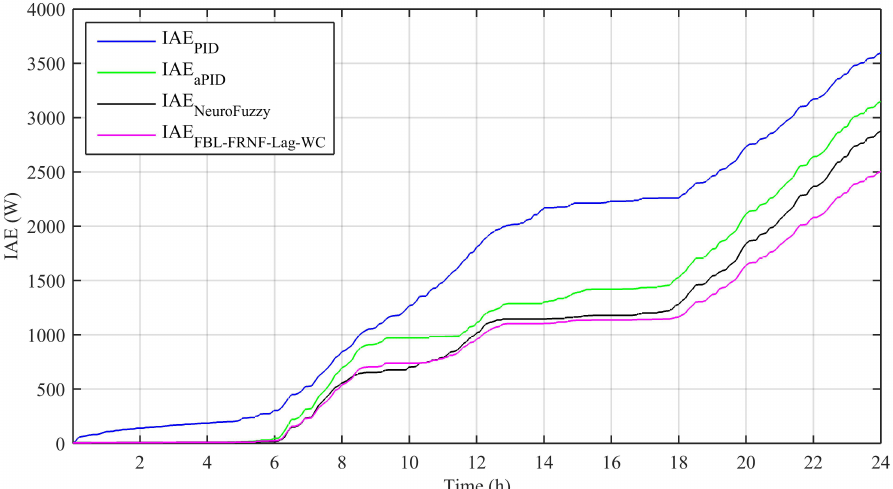
Figure 10. Integral absolute error (IAE)